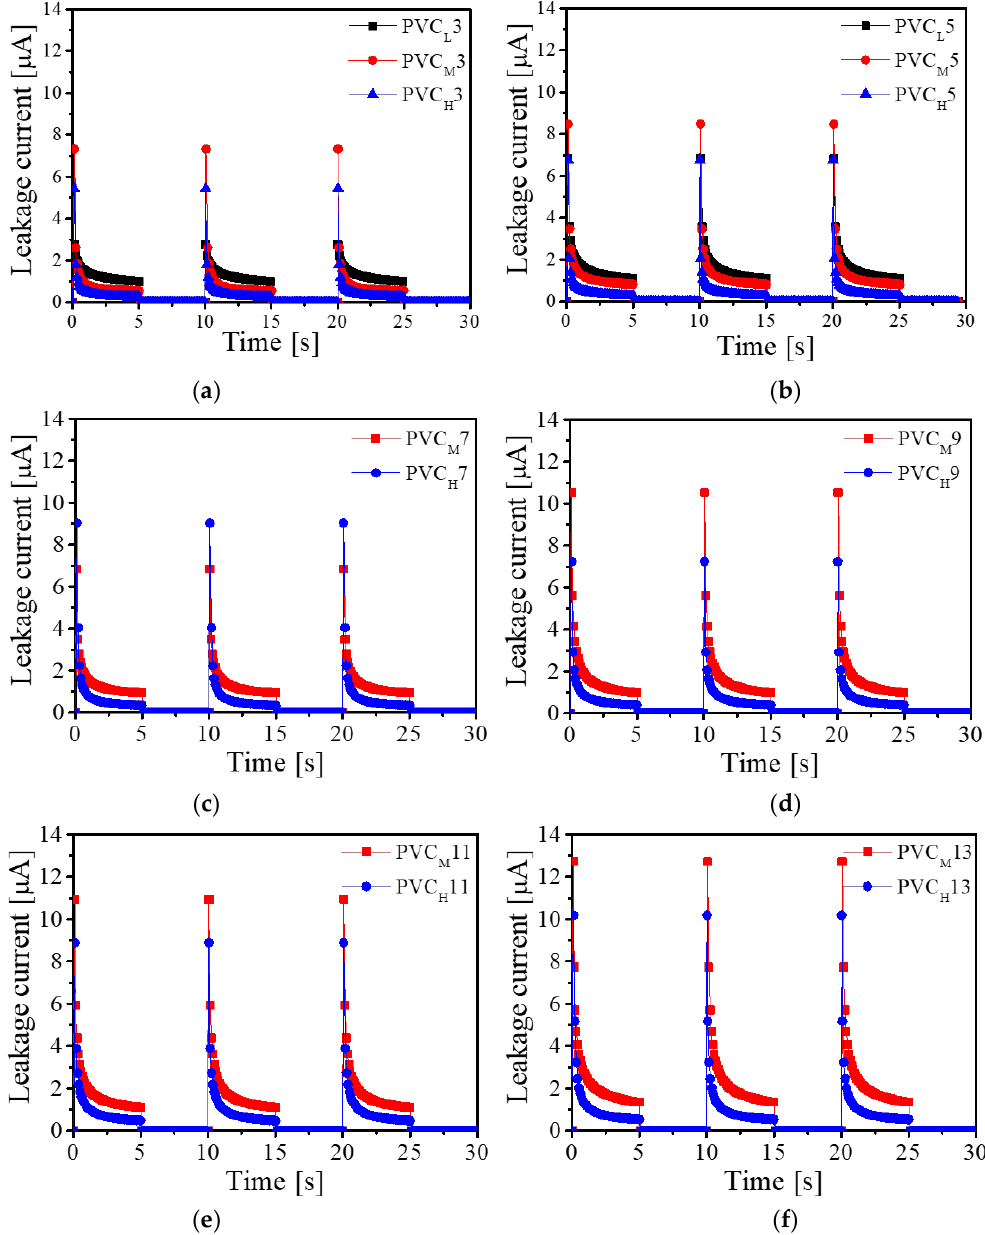
Figure 8. Experimental results for the leakage current of the PVC gels: different molecular weights of PVC with the weight ratio of PVC to DBA plasticizer of ( a ) 1:3, ( b ) 1:5, ( c ) 1:7, ( d ) 1:9, ( e ) 1:11, and ( f ) 1:13.